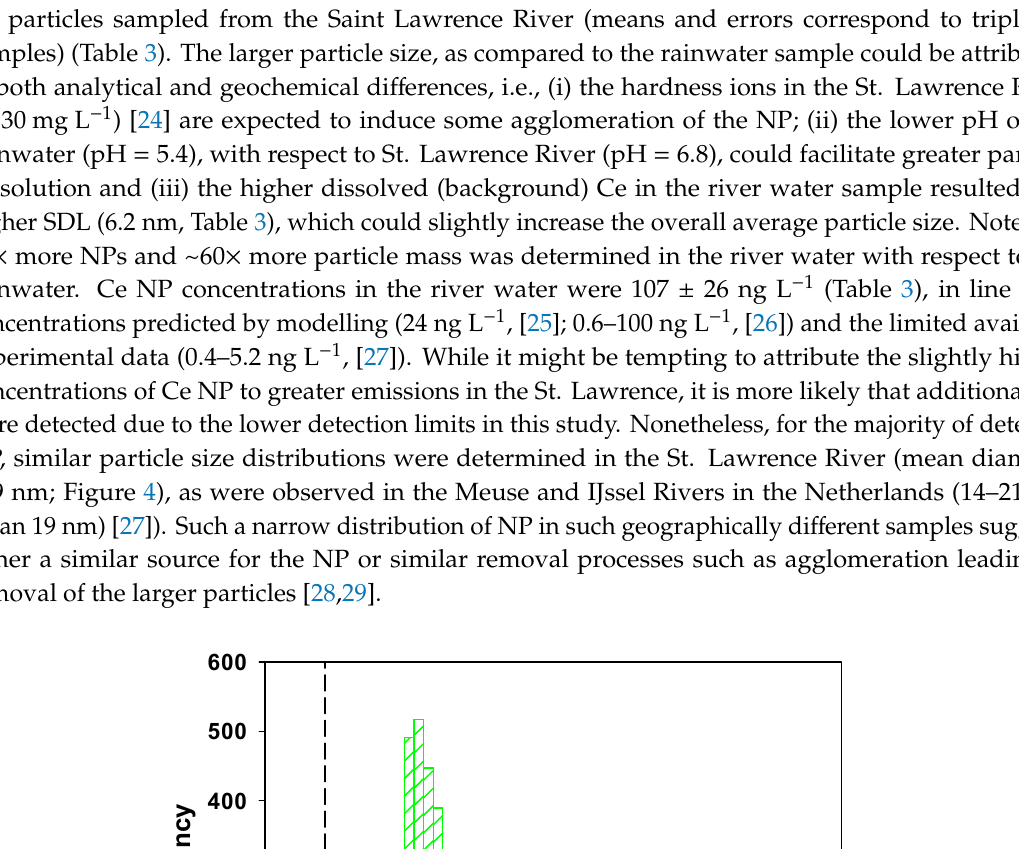
7 of 16 Figure 3. Particle size distribution of a suspension of CeO 2 NPs with a nominal size of 1–10 nm. NP were spiked into ( A ) Milli-Q water or ( B ) rainwater. ( C ) Particle size distribution for Ce-containing NPs in rainwater, determined under the assumption that they were spherical CeO 2 NPs with a density of 7.13 kg dm − 3 [23]. The dashed line corresponds to the SDL. The mean particle size ± polydispersity of the CeO 2 NPs was ( A ) 11.0 ± 5.8 nm; ( B ) 7.7 ± 2.4 nm and ( C ) 9.2 ± 6.1 nm. Measurements were obtained using the wet-SF-ICP-MS with a 50 µs dwell time.